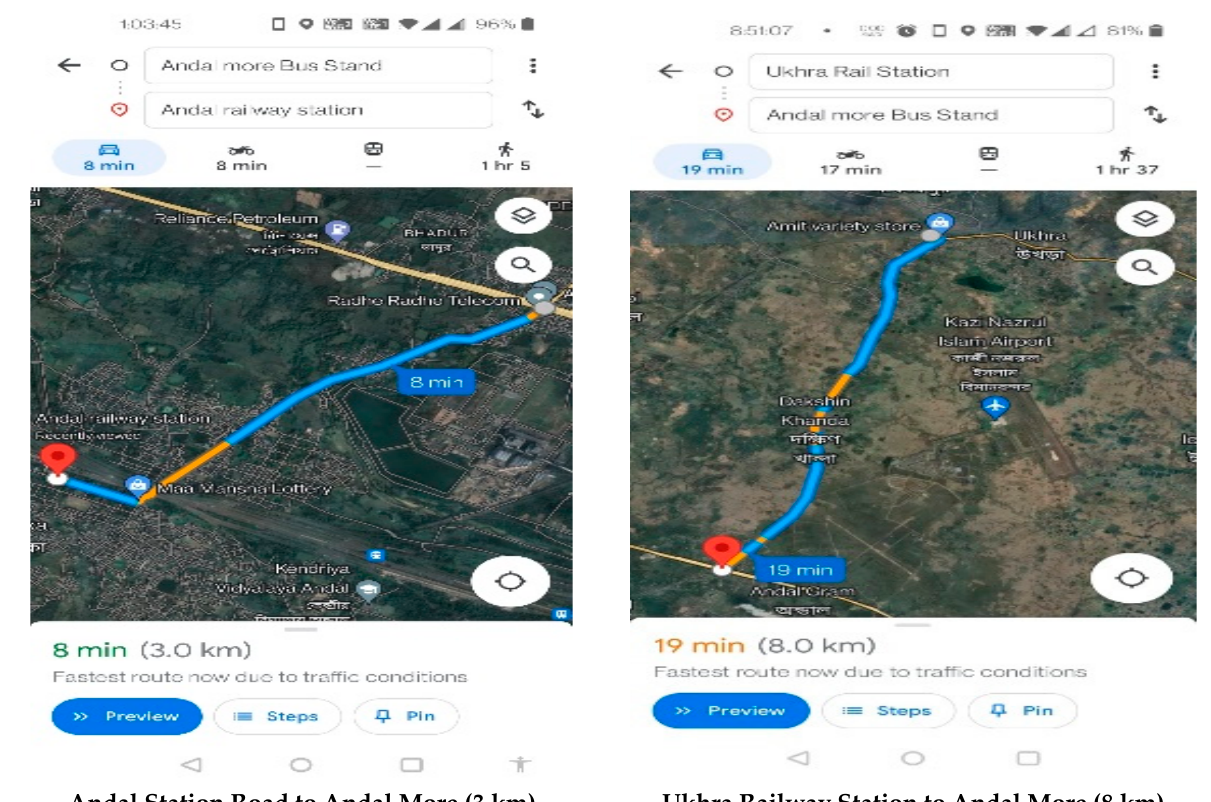
Figure 7. Description of path name with distance using Google Maps. Using Phase 1 of our proposed algorithm, we have obtained an equivalent bidirectional graph, which is shown in Figure 8.